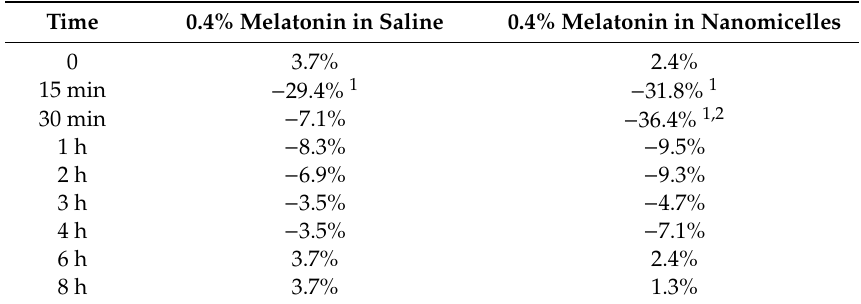
Table 1. Statistical analysis of data shown in Figure 2. Di ff erences were calculated with respect to the intraocular pressure measured in rats instilled with